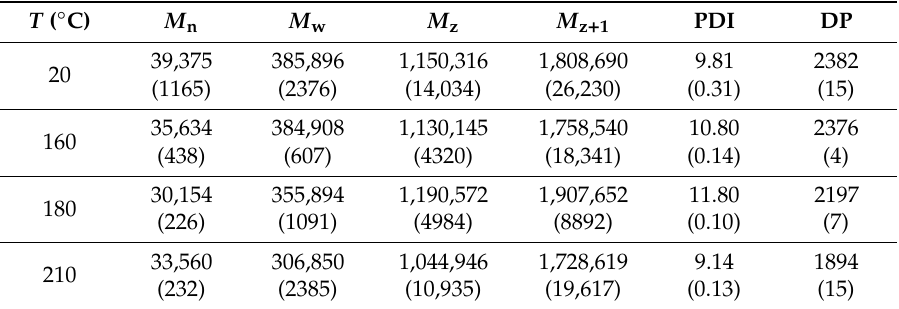
Table 3. SEC results of oak wood cellulose before and after thermal treatment a,b .